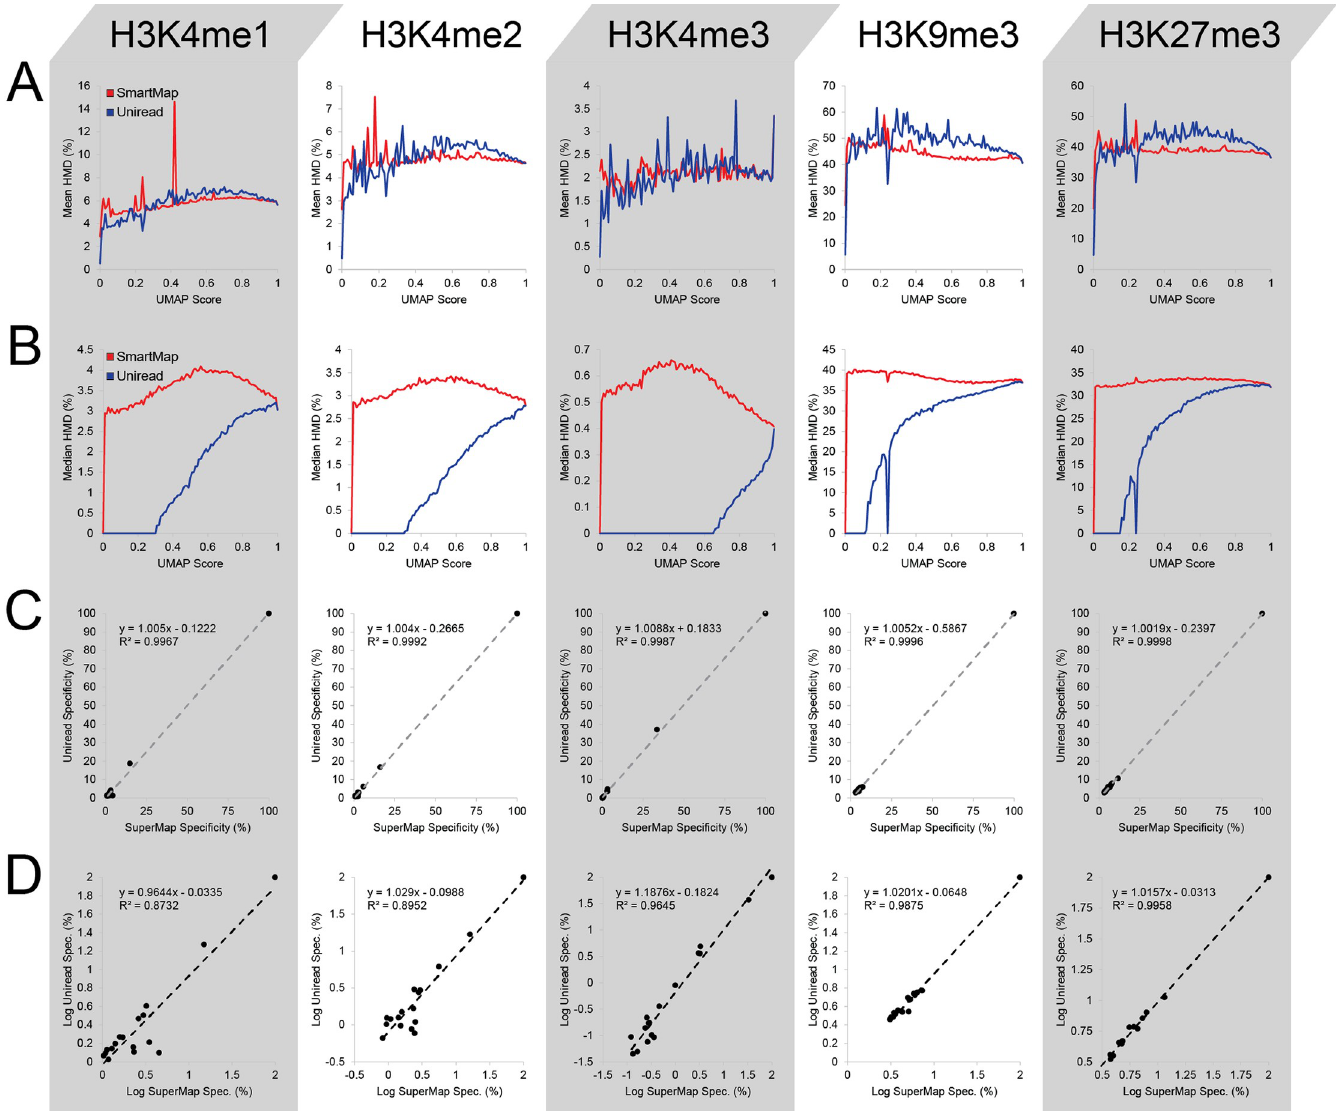
Fig 5. ICeChIP-seq histone modification density in SmartMap and uniread analyses. All analyses conducted on 200bp tiled genomic windows. (A-B) (A) Mean or (B) Median HMD vs. mappability score (UMAP50) for SmartMap and uniread analyses. (C-D) Scatterplots of (C) specificity or (D) log specificity for uniread vs. SmartMap analyses. Specificity is measured as the enrichment of each on- or off-target internal standard nucleosome as a percentage of on-target